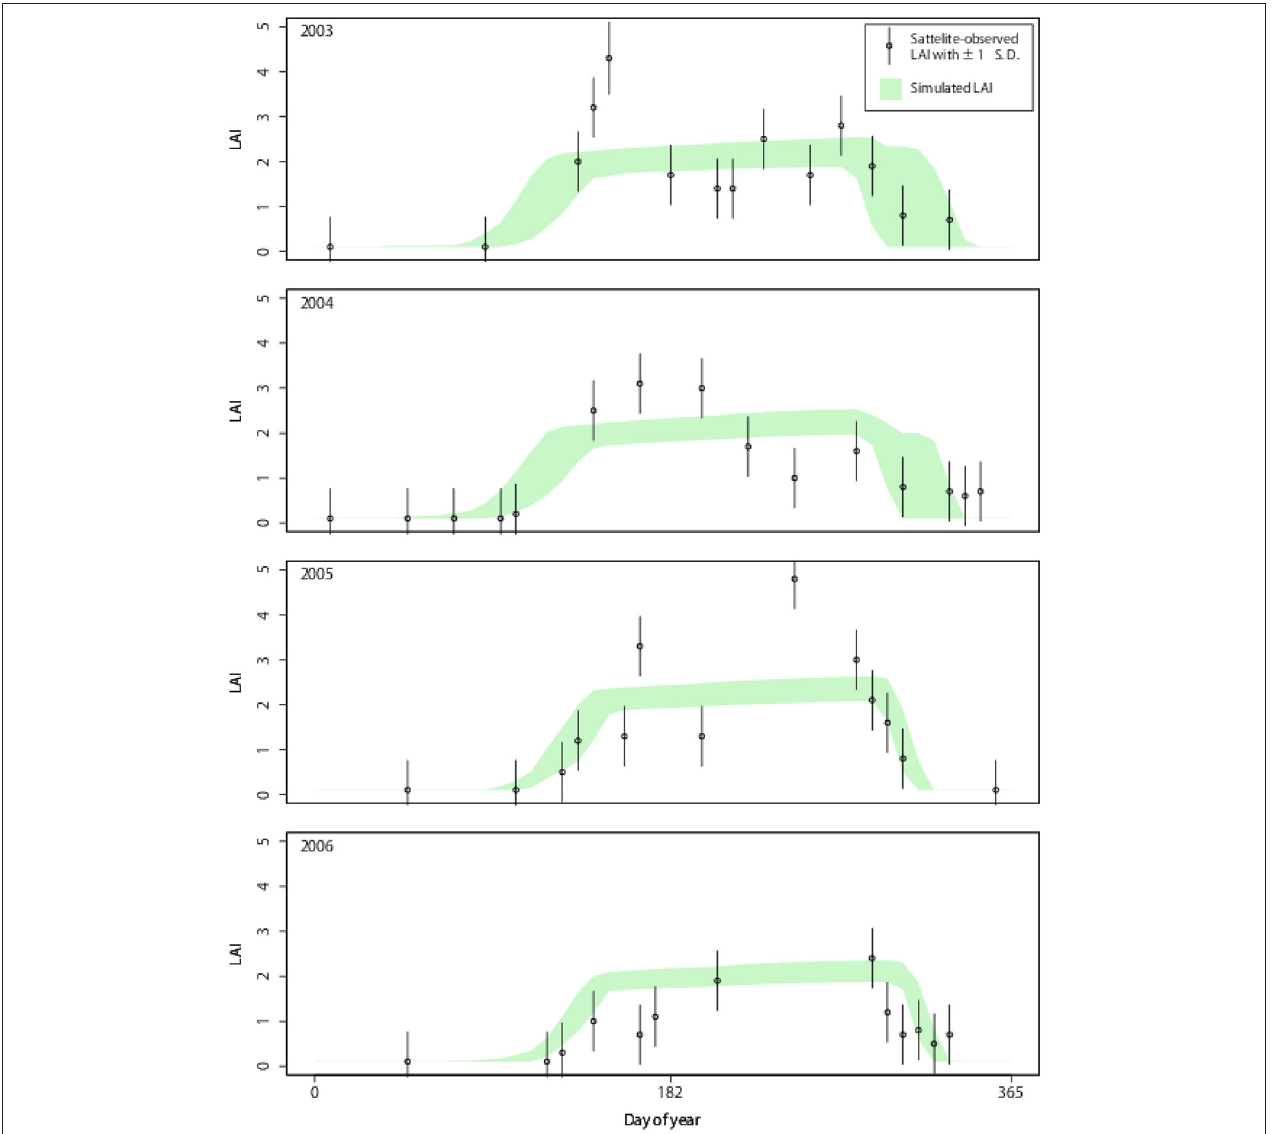
FIGURE 2 | Point simulation for LAI dynamics from 2003 to 2006 in mid-eastern Japan (36.933N; 139.066 E). Simulated LAI shows the 5th to 95th percentile range of the 5,000 simulation